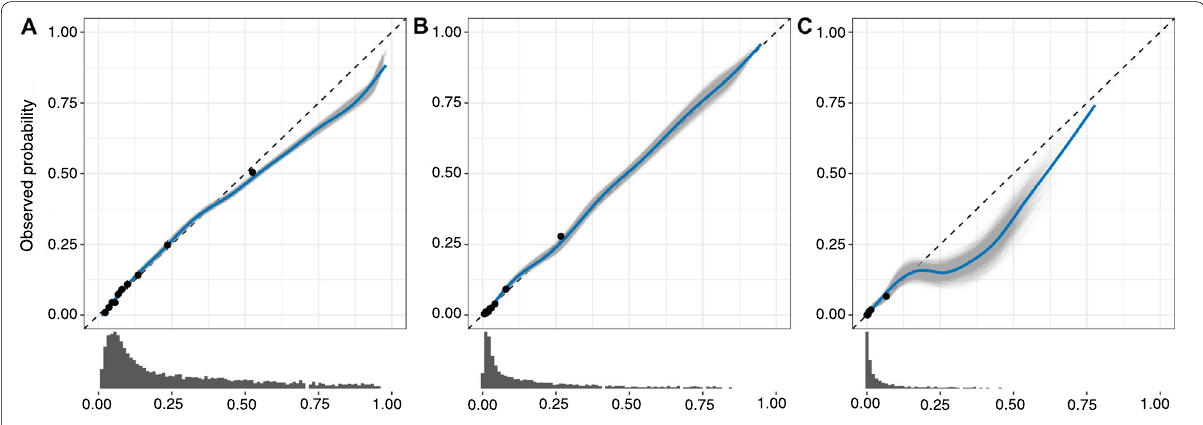
Fig. 2 Optimism-corrected calibration curves of the prognostic model illustrate the relationship between the observed and predicted probability of urgent care visit or worse ( A ), hospitalization or worse ( B ) and admission to intensive care unit or death ( C ). The sample distribution of predicted probabilities is presented as marginal histograms. The sample is divided into 10 equally large groups of predicted probability and the mean observed probability of each group depicted as a black dot and point range centered at the mean predicted probability of the group. The weighted scatterplot smoothing (LOWESS) relationship between the observed and predicted probabilities of bootstrap resamples with replacement from 2000 imputed datasets are shown as individual thin gray lines with the mean relationship shown as a blue line. These are compared to the dashed black line, reflecting a perfect relationship between observed and predicted